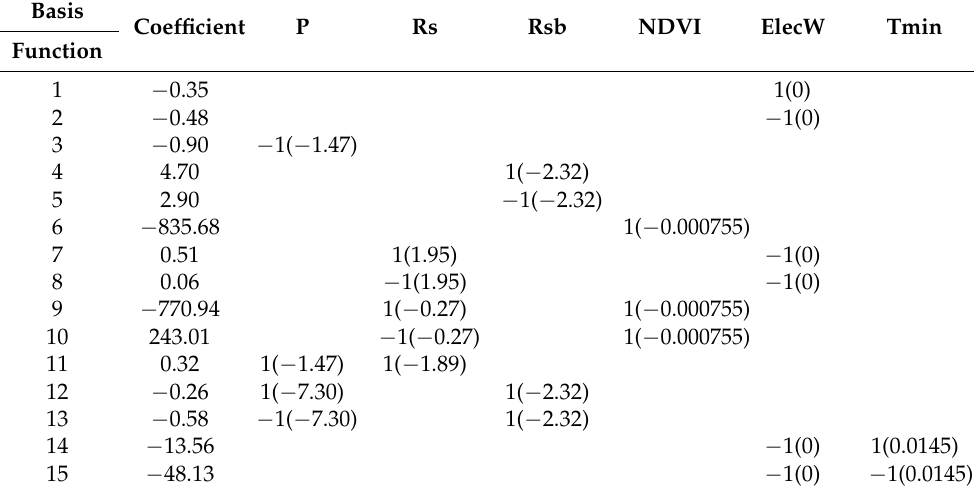
Table 2. A list of the variables retained by MARS and their corresponding basic equations with coefficient and node value.